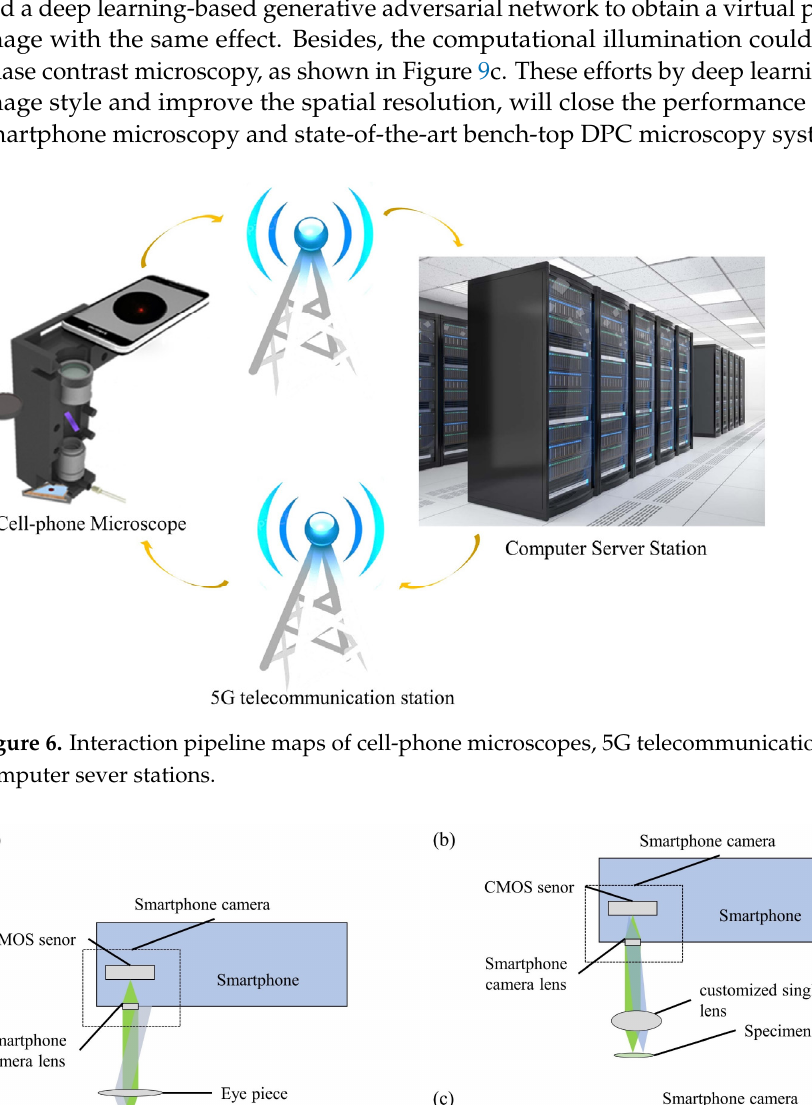
Figure 8. Smartphone-based bright-field microscope with deep learning. ( a ) Deep learning en- hanced mobile-phone microscopy [77], and ( b ) a photograph of the smartphone-based bright-field microscope. [78]. 3.1. Smartphone-Based Phase Contrast Microscopy Image vision contrast in clinical microscopy is often achieved by chemical staining or labeling. By these dying methods, specific features of the sample can be enhanced, but they require extensive sample preparation. Label-free phase contrast imaging techniques do not require staining, and have not been developed for several years. Due to the higher cost of the associated optical hardware and the complexity of the system, their applica- tions are limited. Now, computational, low-cost and portable microscopes based on smartphone platforms make label-free phase contrast techniques useful and possible in the fields of on-site testing and remote medical diagnosis [79–82]. To improve the quality of phase contrast images collected by smart-phone microscopes, deep learning networks